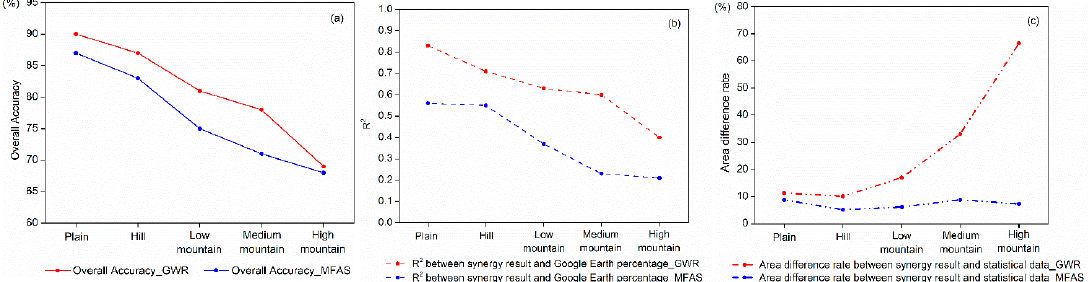
Figure 8. Performance assessment and comparisons including spatial accuracy ( a ), consistency with cropland percentage ( b ), and consistency with statistics ( c ) using various landscapes.